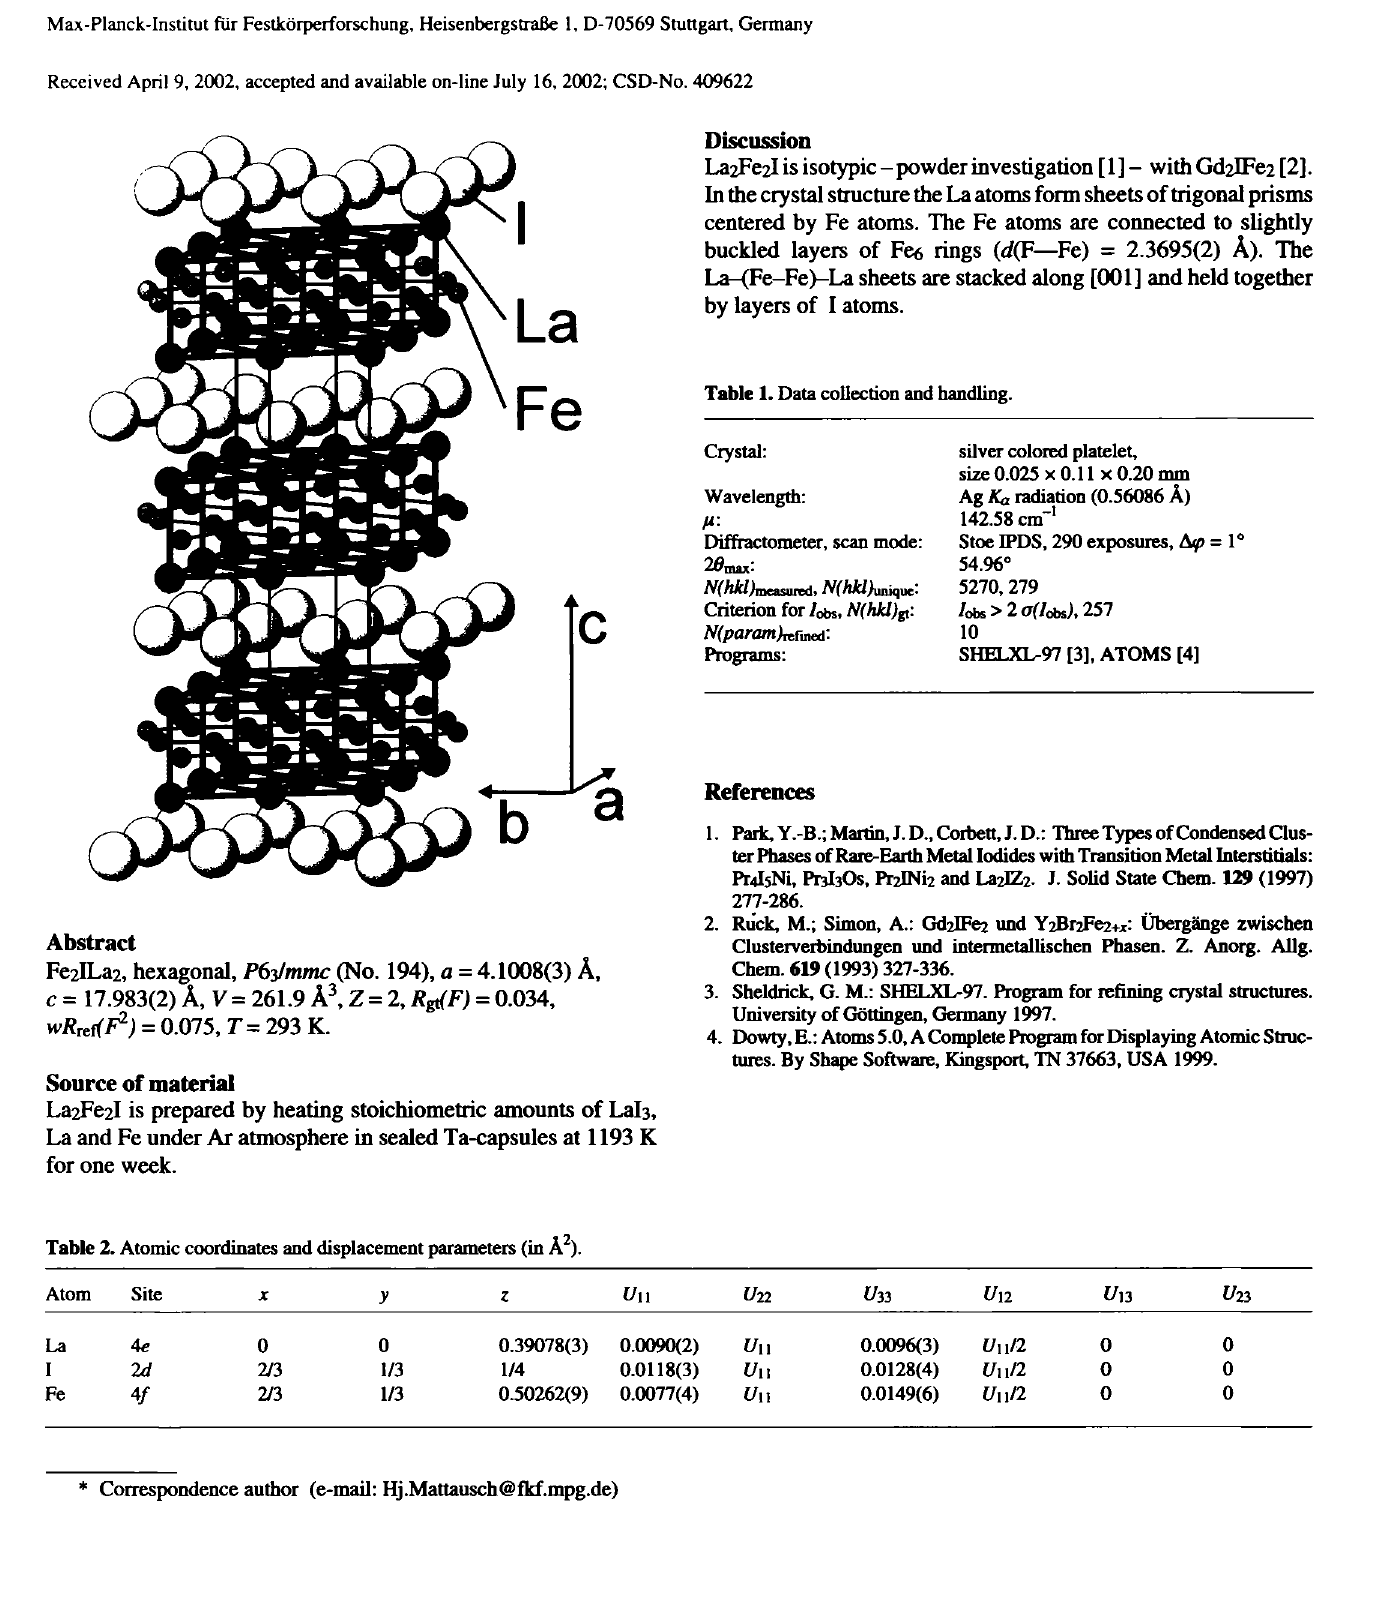
Table 2. Atomic coordinates and displacement parameters (in Â 2